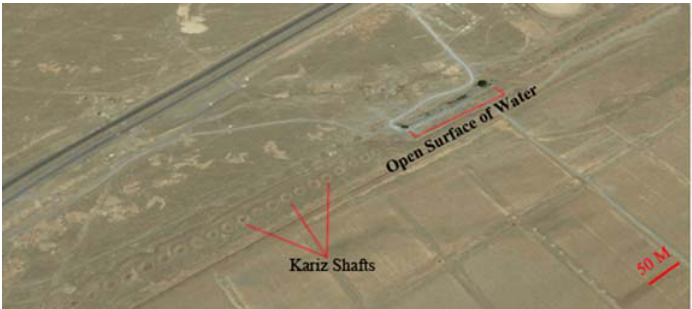
Figure 6. Hassan-Abad’s Kariz with chain of wells (from Google earth). Open surface of water (canal) and wells pattern.